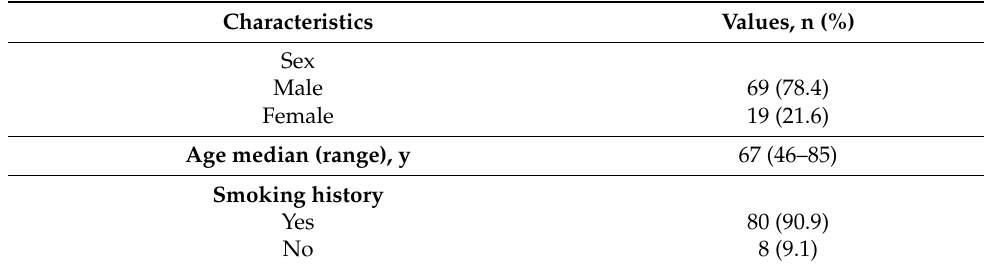
Table 1. Baseline demographic and clinical characteristics of